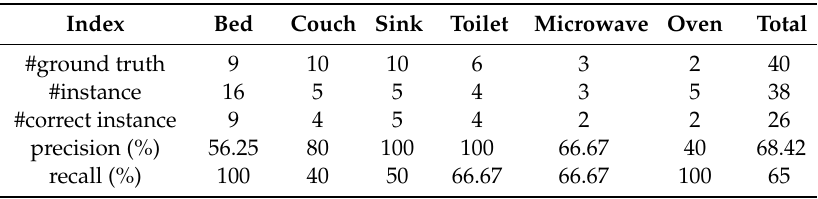
Table 5. The statistical results of all the